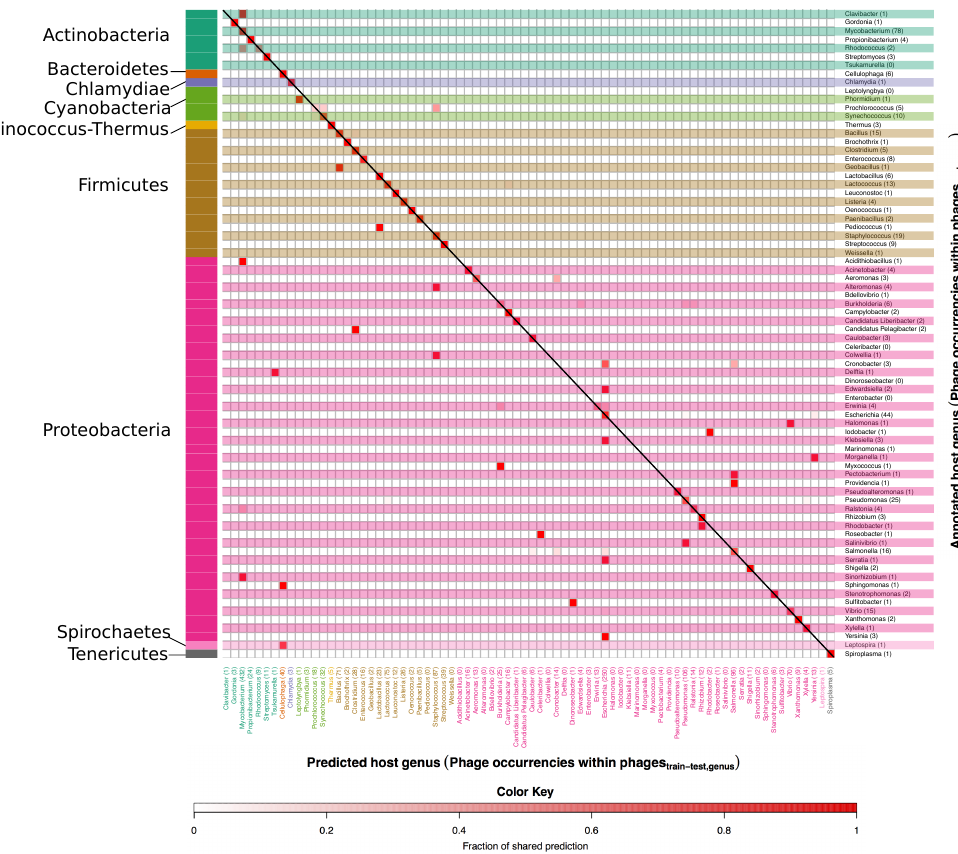
Figure 7. Heatmap of annotated vs. predicted host genera in the phages correct as well as mispredicted host genera can be seen. Annotated host genera are listed along the y axis, while predicted ones are on the x axis. The number after each genus on the y axis and the x axis indicate the number of occurrences of phages in the phage respectively. Host genera are grouped according to the respective phylum, which are indicated on the left side of the figure. The colour scale indicates the fraction of phages predicted as targeting a particular host and goes from white, no phages, to intense red, 100% of the phages. Accordingly, the colour is in itself not an indicator of correctness of the prediction, and red colours along the diagonal represent correct